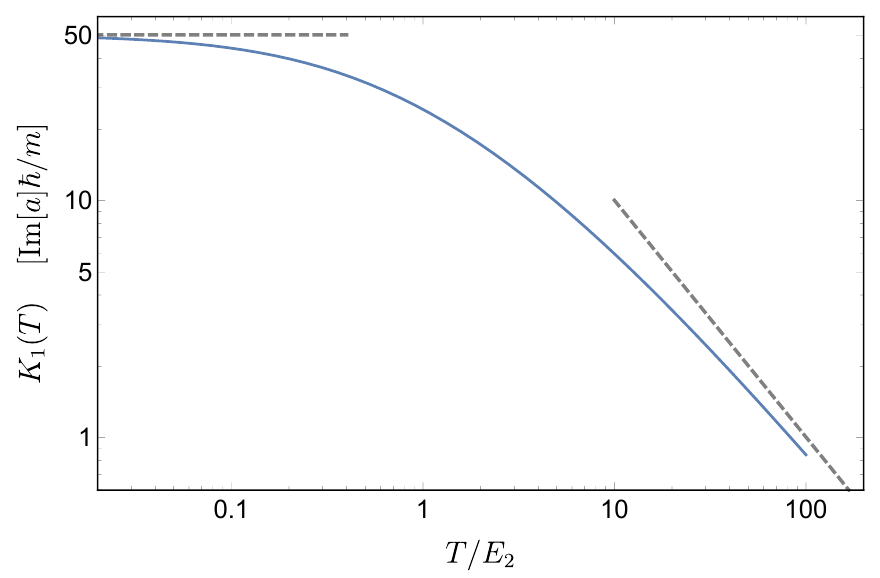
Figure 3 . Rate coe(cid:14)cient K 1 ( T ) for dimer breakup as a function of the temperature T . The dashed lines indicate its asymptotic behaviors in the low- T and high- T